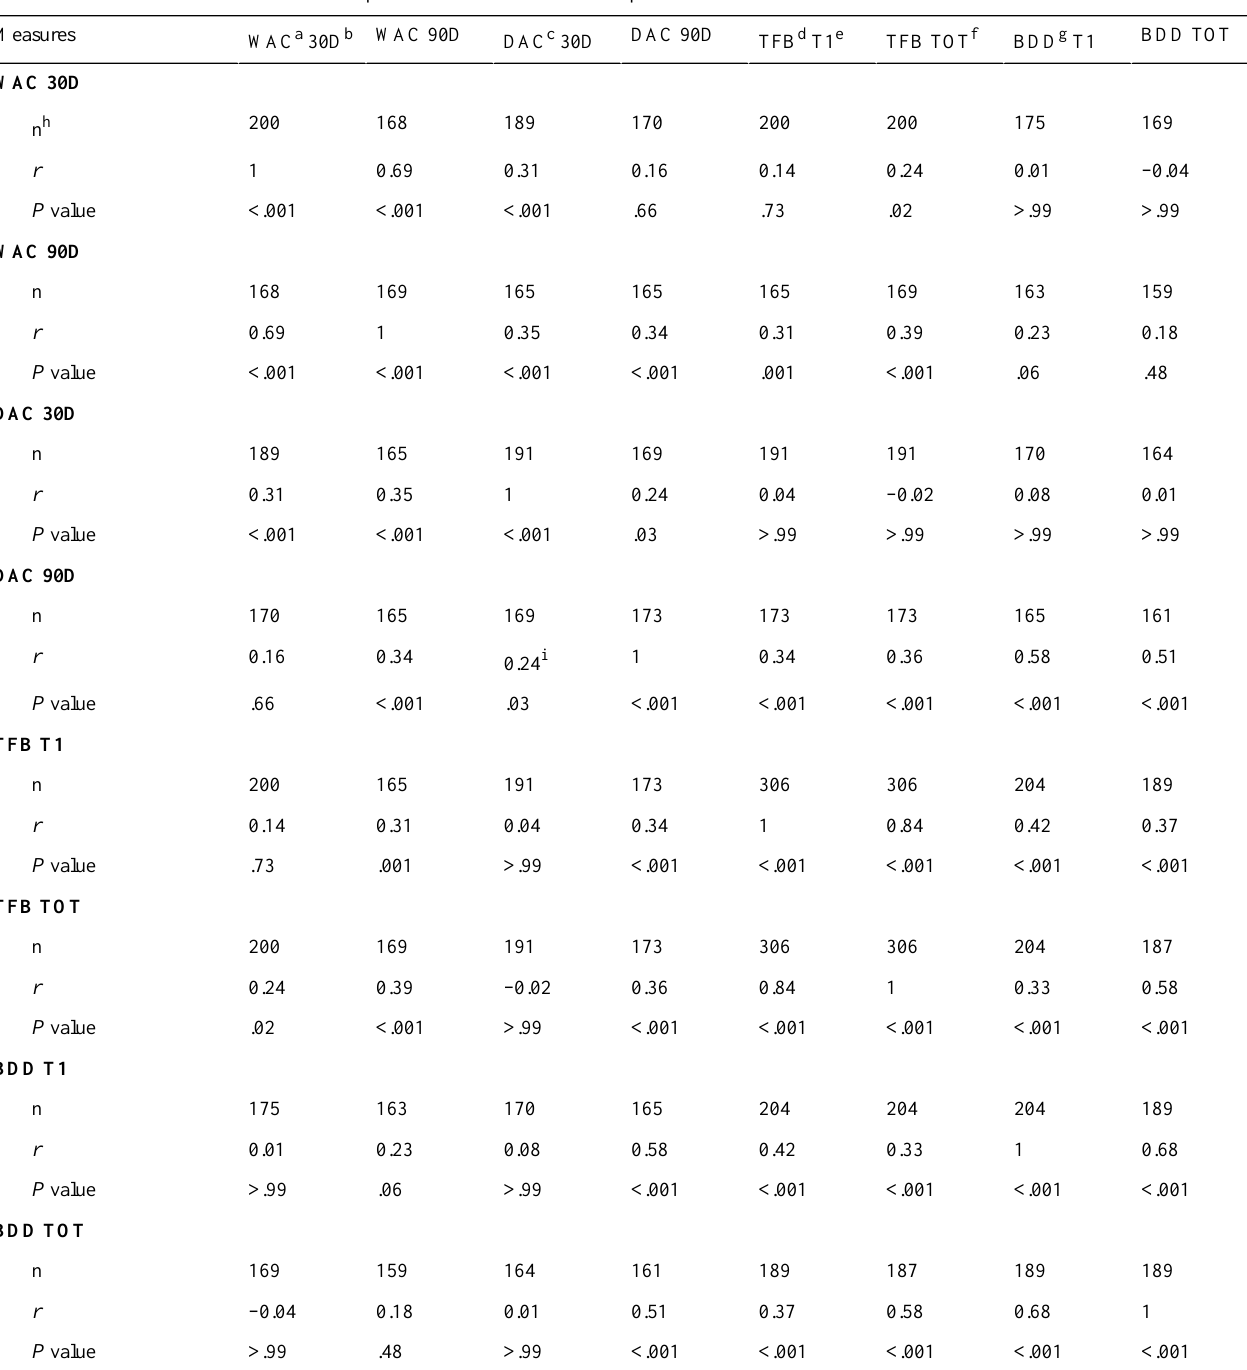
Table 4. Correlations between intervention questionnaires and assessment